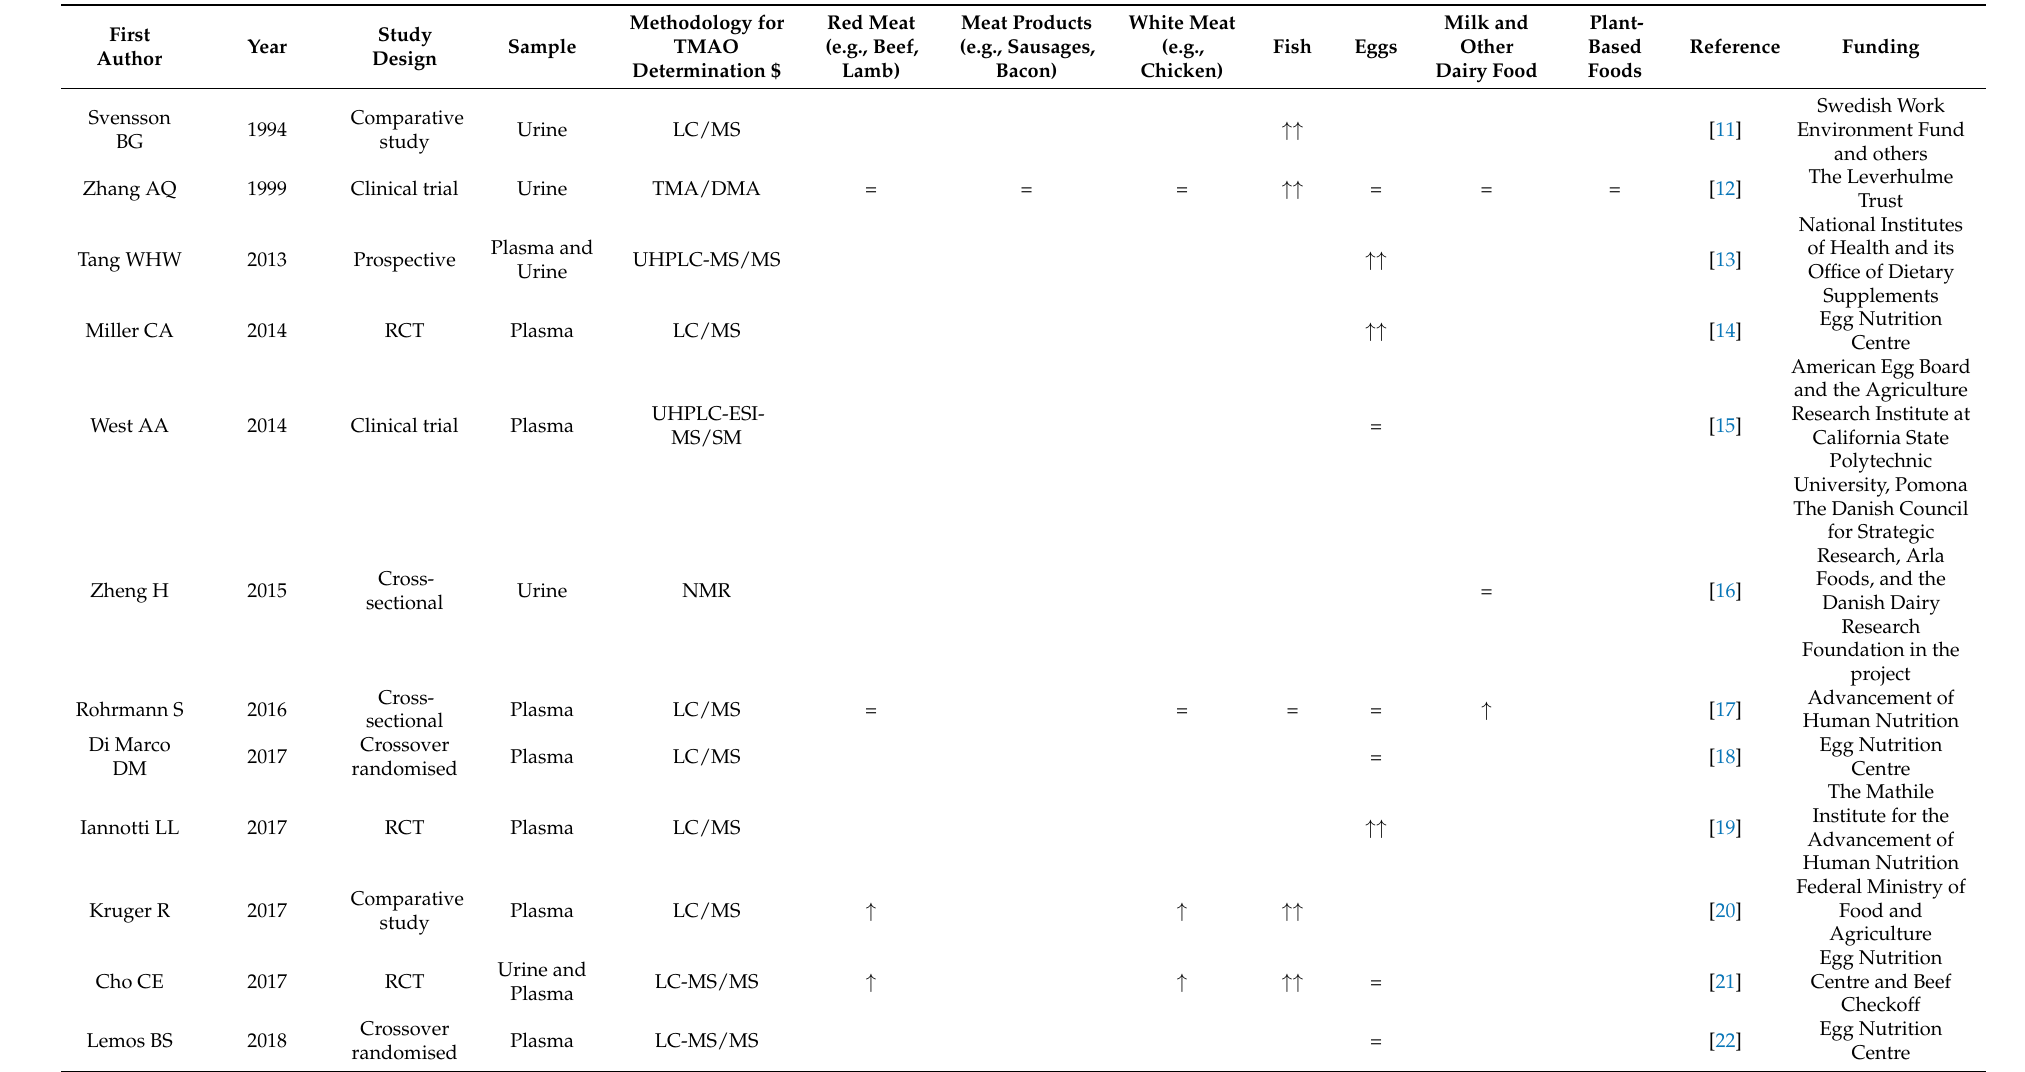
Table 1. Differences of urinary or plasmatic trimethylamine (TMAO) production from foods following human